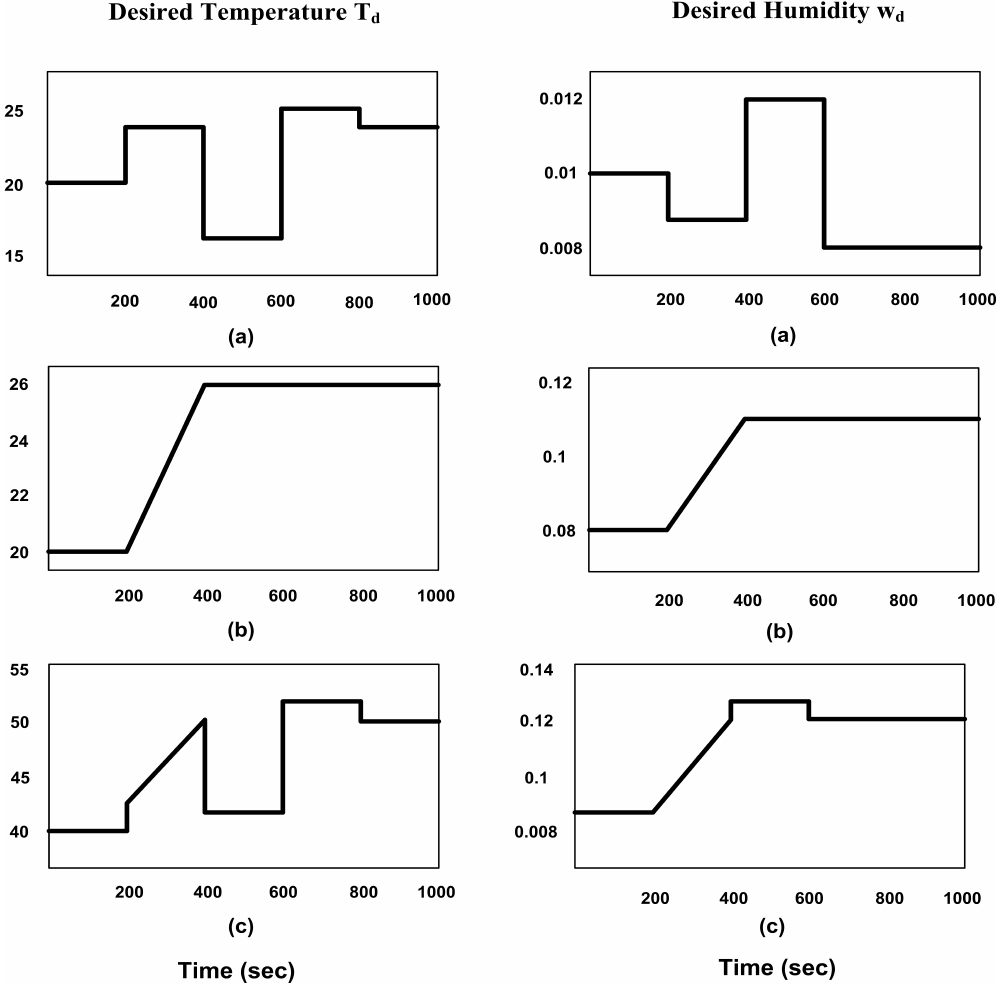
Figure 4. Desired input sequence for humidity ratio and temperature including, ( a ) sequence of steps; ( b ) steps with ramp; ( c ) integration of